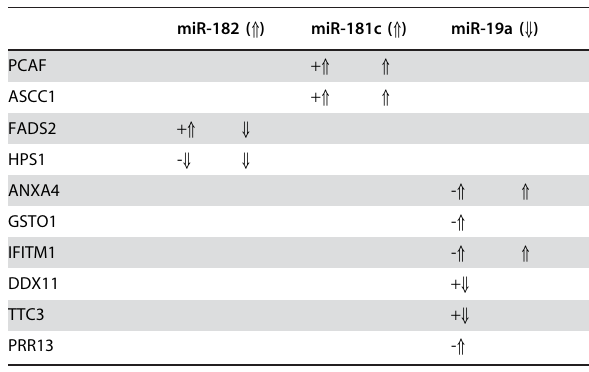
Table 3. Validation of highly correlated pairs. .. ... .... ... ... .... ... ... .... ... ... .... ... ... .... ... ... .... ... ... .... .